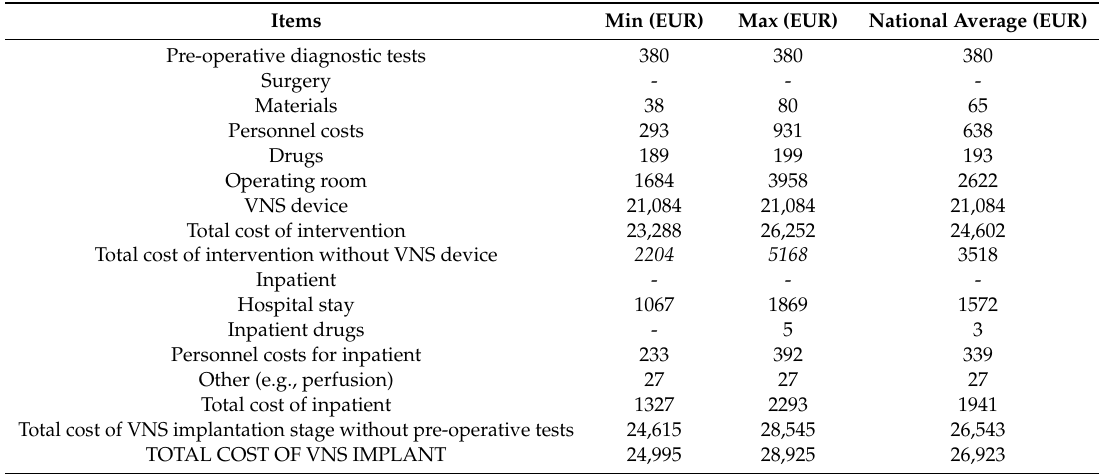
Table 4. Full average cost of VNS implantation